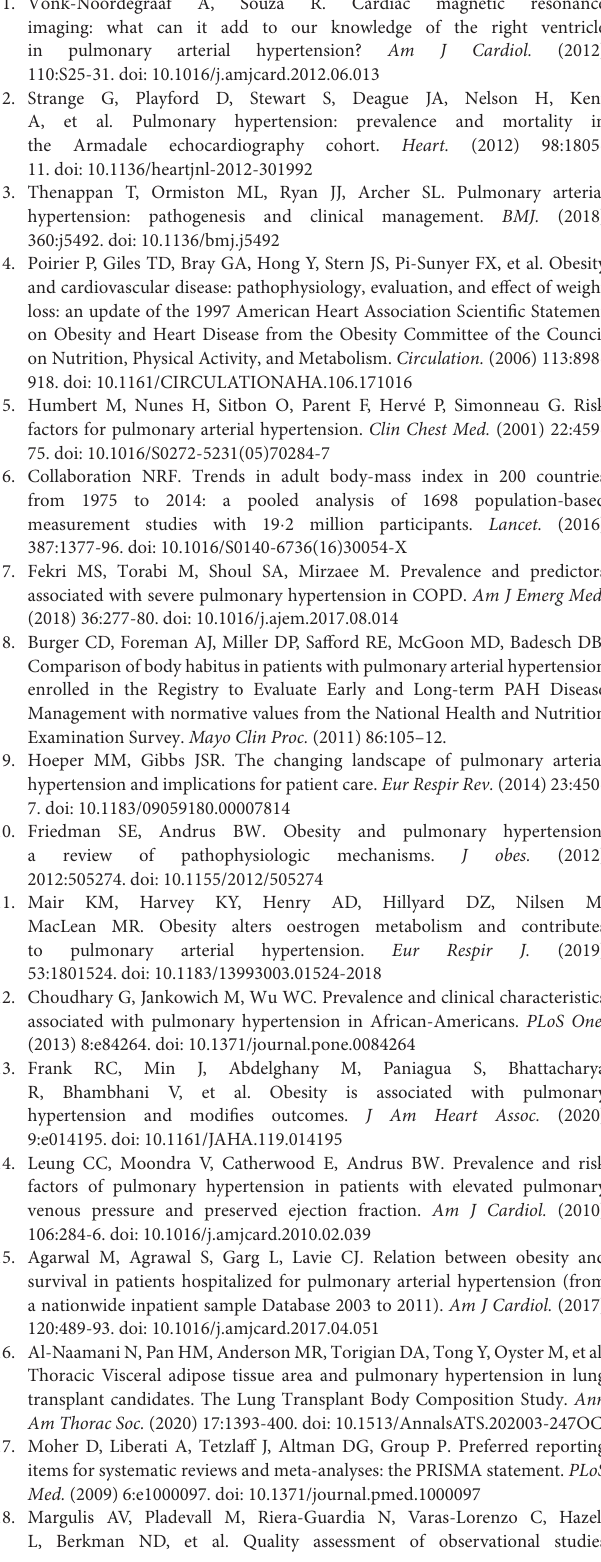
Frontiers in Medicine |